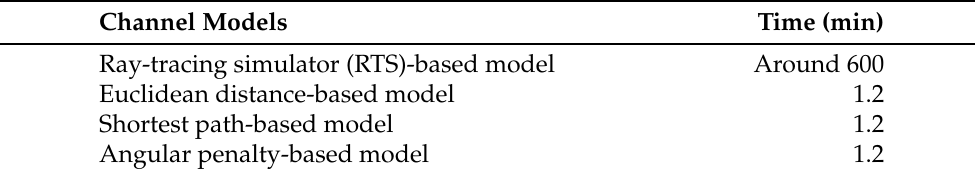
Table 4. The average time required by different models to evaluate the channels for all the possible AP placement in a simplified coverage